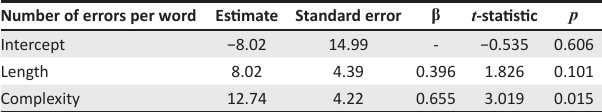
TABLE 3: Linear regression: Pseudoword error predicted. Number of errors per word Estimate Standard